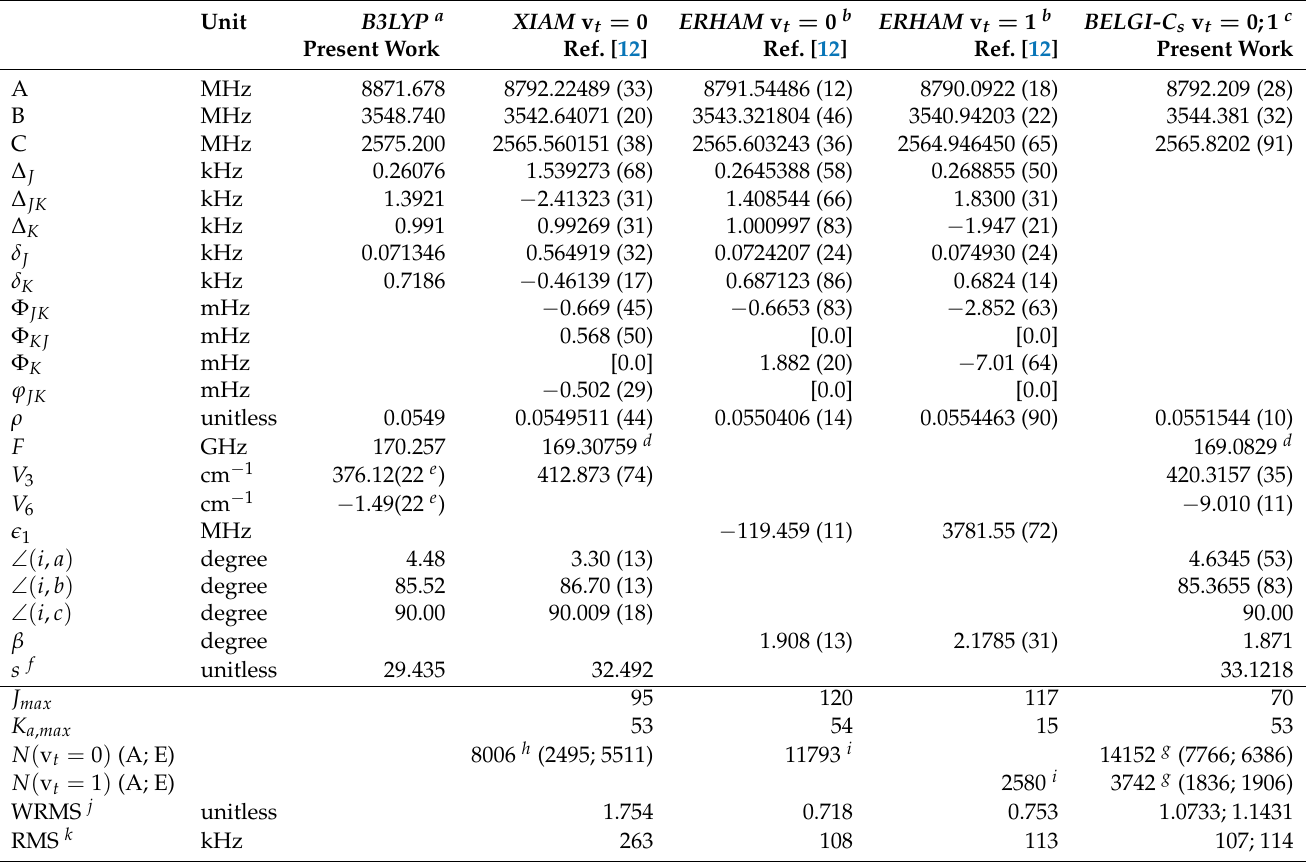
a Calculation with the aug-cc-pVTZ basis set. b The complete set of higher order tunneling terms used in ERHAM are listed in Tables 1 and 2 of Ref. [12]. c Parameters in the PAS after transforming them from the RAM. The complete set of RAM parameters including centrifugal distortion and higher order terms used in our fit are listed in Table S1 of the supplementary data. d In XIAM F is a derived parameter from F 0 , see supplementary data in Ref. [12]. In BELGI -C s F was fixed to the best value obtained by fitting it. e Standard error of the analytical fit based on Equation (5) as given by Gnuplot [24]. f Reduced barrier height: s = 4 V 3 / ( 9 F ) . g N corresponds to the number of assigned transitions for v t = 0 and v t = 1. In the BELGI -C s fit 14152 and 3742 correspond to the number of transitions fitted. h In XIAM only 8006 unblended lines were included in the fit. i In the ERHAM fit 11,793 and 2580 correspond to the number of distinct frequencies used for the fits of Ref. [12]. j WRMS is the weighted unitless root mean square deviation of the fit: